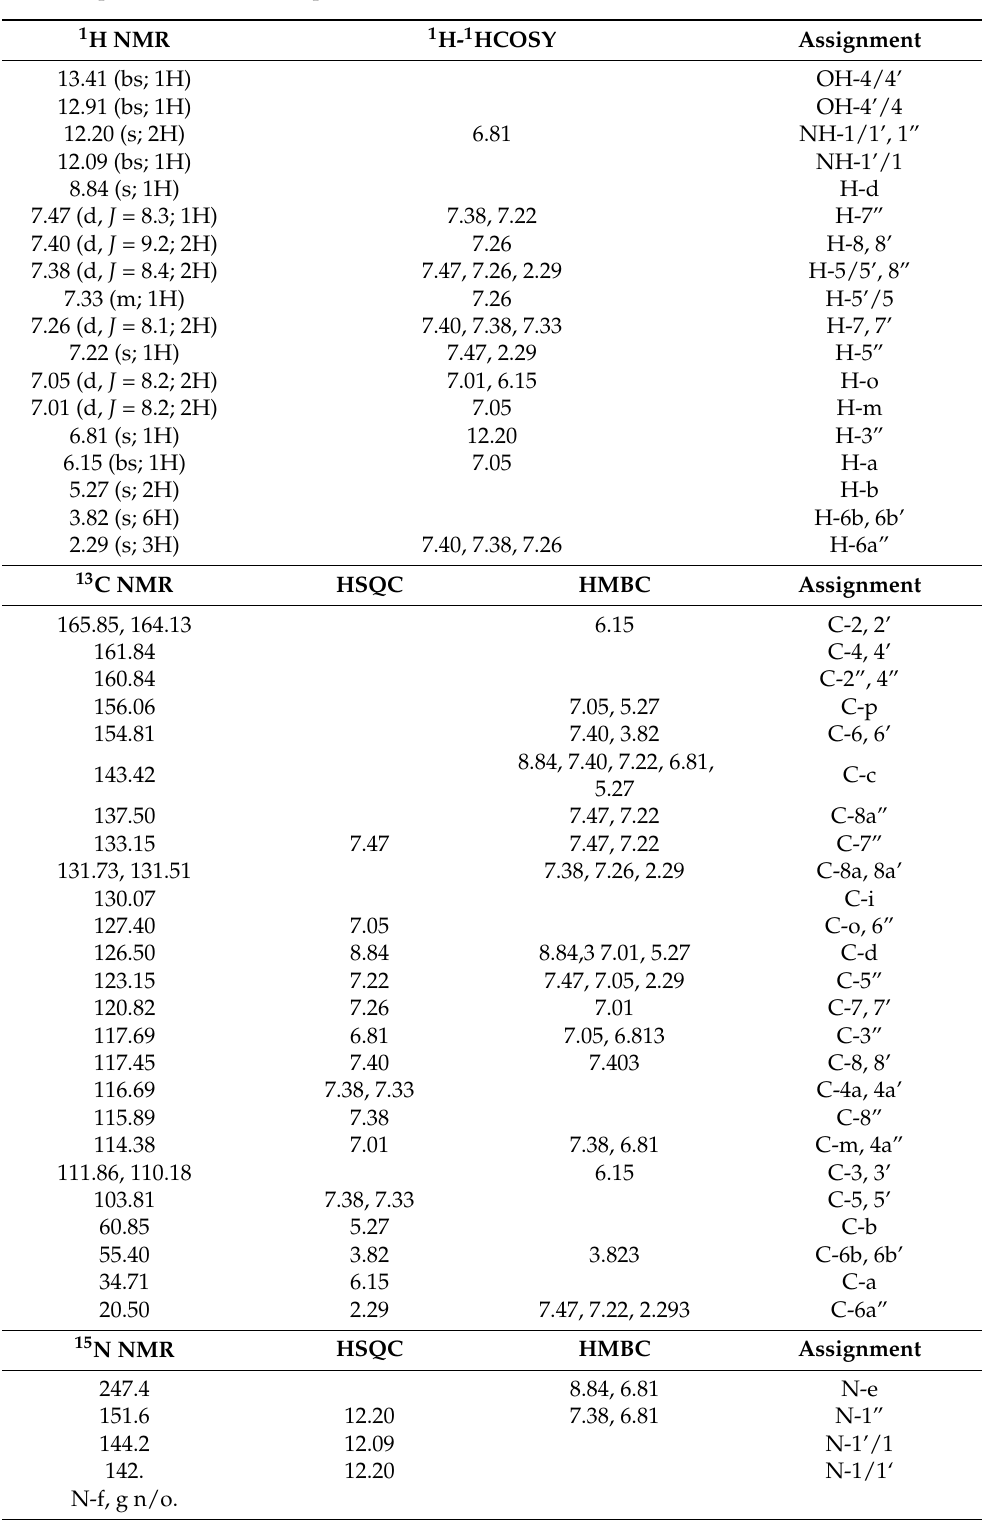
Table 2. Spectrum data for compound 8f